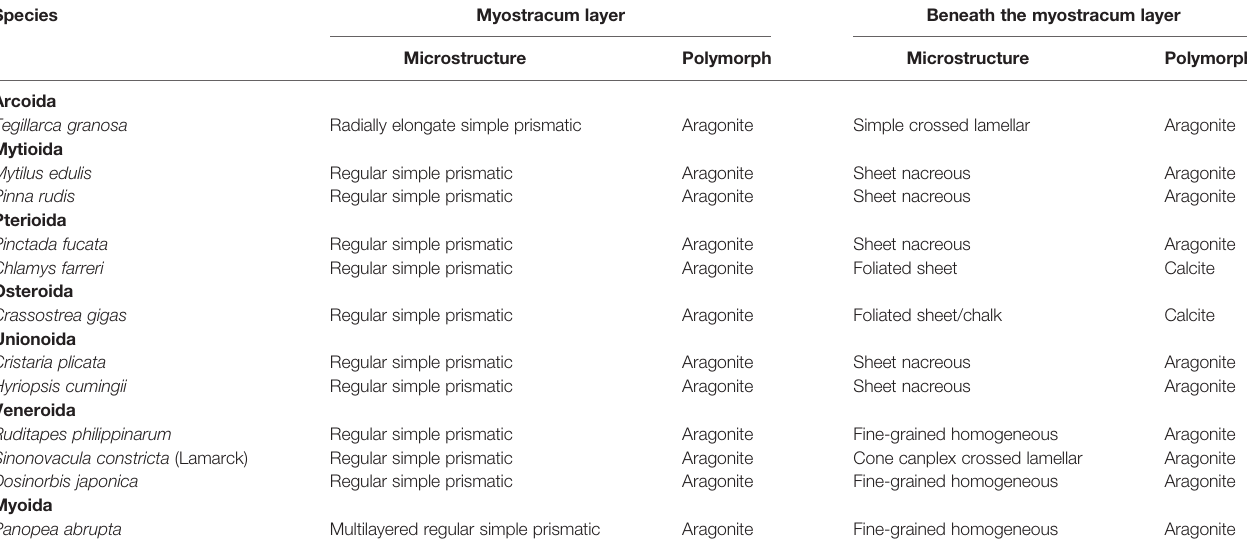
TABLE 1 | Summary of the microstructure and texture of tested shell layers in